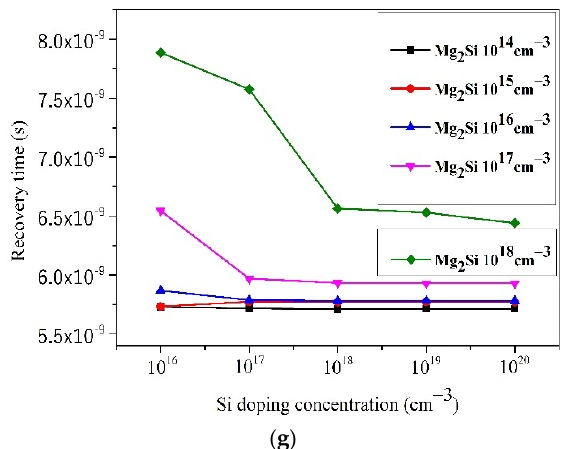
Figure 11. Response time and the recovery time curves of the heterojunction PDs with different doping concentrations. ( a ) Si–10 16 cm − 3 . ( b ) Si–10 17 cm − 3 . ( c ) Si–10 18 cm − 3 . ( d ) Si–10 19 cm − 3 . ( e ) Si–10 20 cm − 3 . ( f ) The effect of doping concentrations on response time. ( g ) The effect of doping concentrations on recovery time.